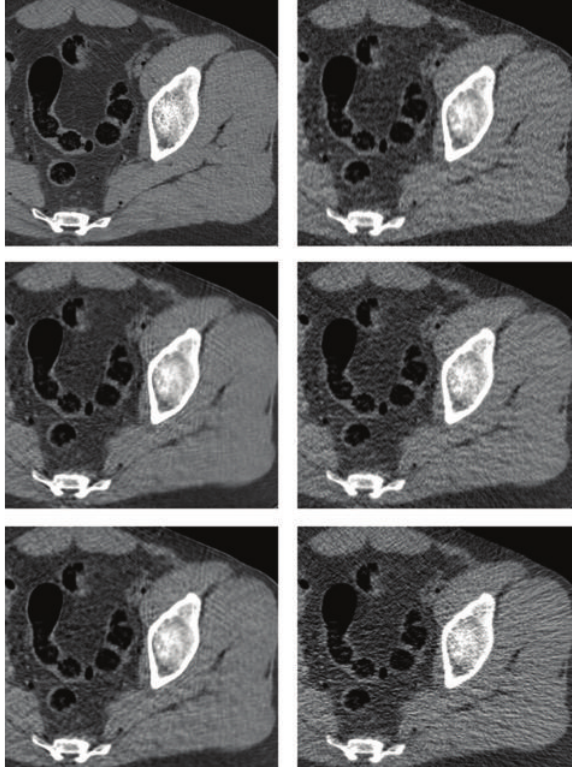
Figure 7: Reconstruction of a test image (thighs’ section). Images are listed left to right and displayed in HU range of [−220, 350] . Upper row: reference image, PWLS. Middle row: our method (stage II), ATM. Lower row: our method (stage I),